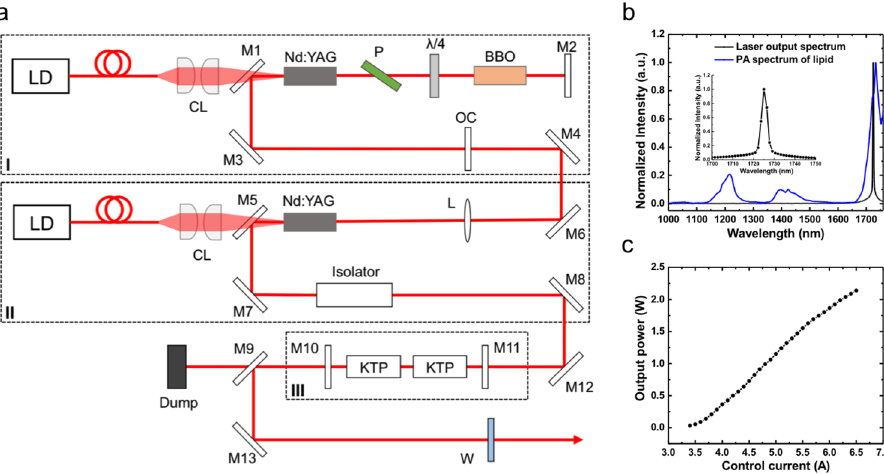
Figure 2. 1.7 µ m 2 kHz MOPA-pumped OPO for high-speed optical excitation. ( a ) Schematic of MOPA- pumped OPO. Dashed boxes labeled by I, II, and III highlight the master oscillator, optical power amplifier, and OPO, respectively. LD, laser diode; CL, coupling lens; M1 and M5, fold mirror; M2, M10, and M11, flat mirror; M3, M4, M6, M7, M8, M12, and M13, reflective mirror; M9, dichroic mirror; P, polarizer; BBO, beta barium borate Pockels cell; OC, output coupler; L, lens; KTP, potassium titanyl phosphate; W, output window. ( b ) Output wavelength of the laser (black curve), 1725 nm, matching the maximum peak in